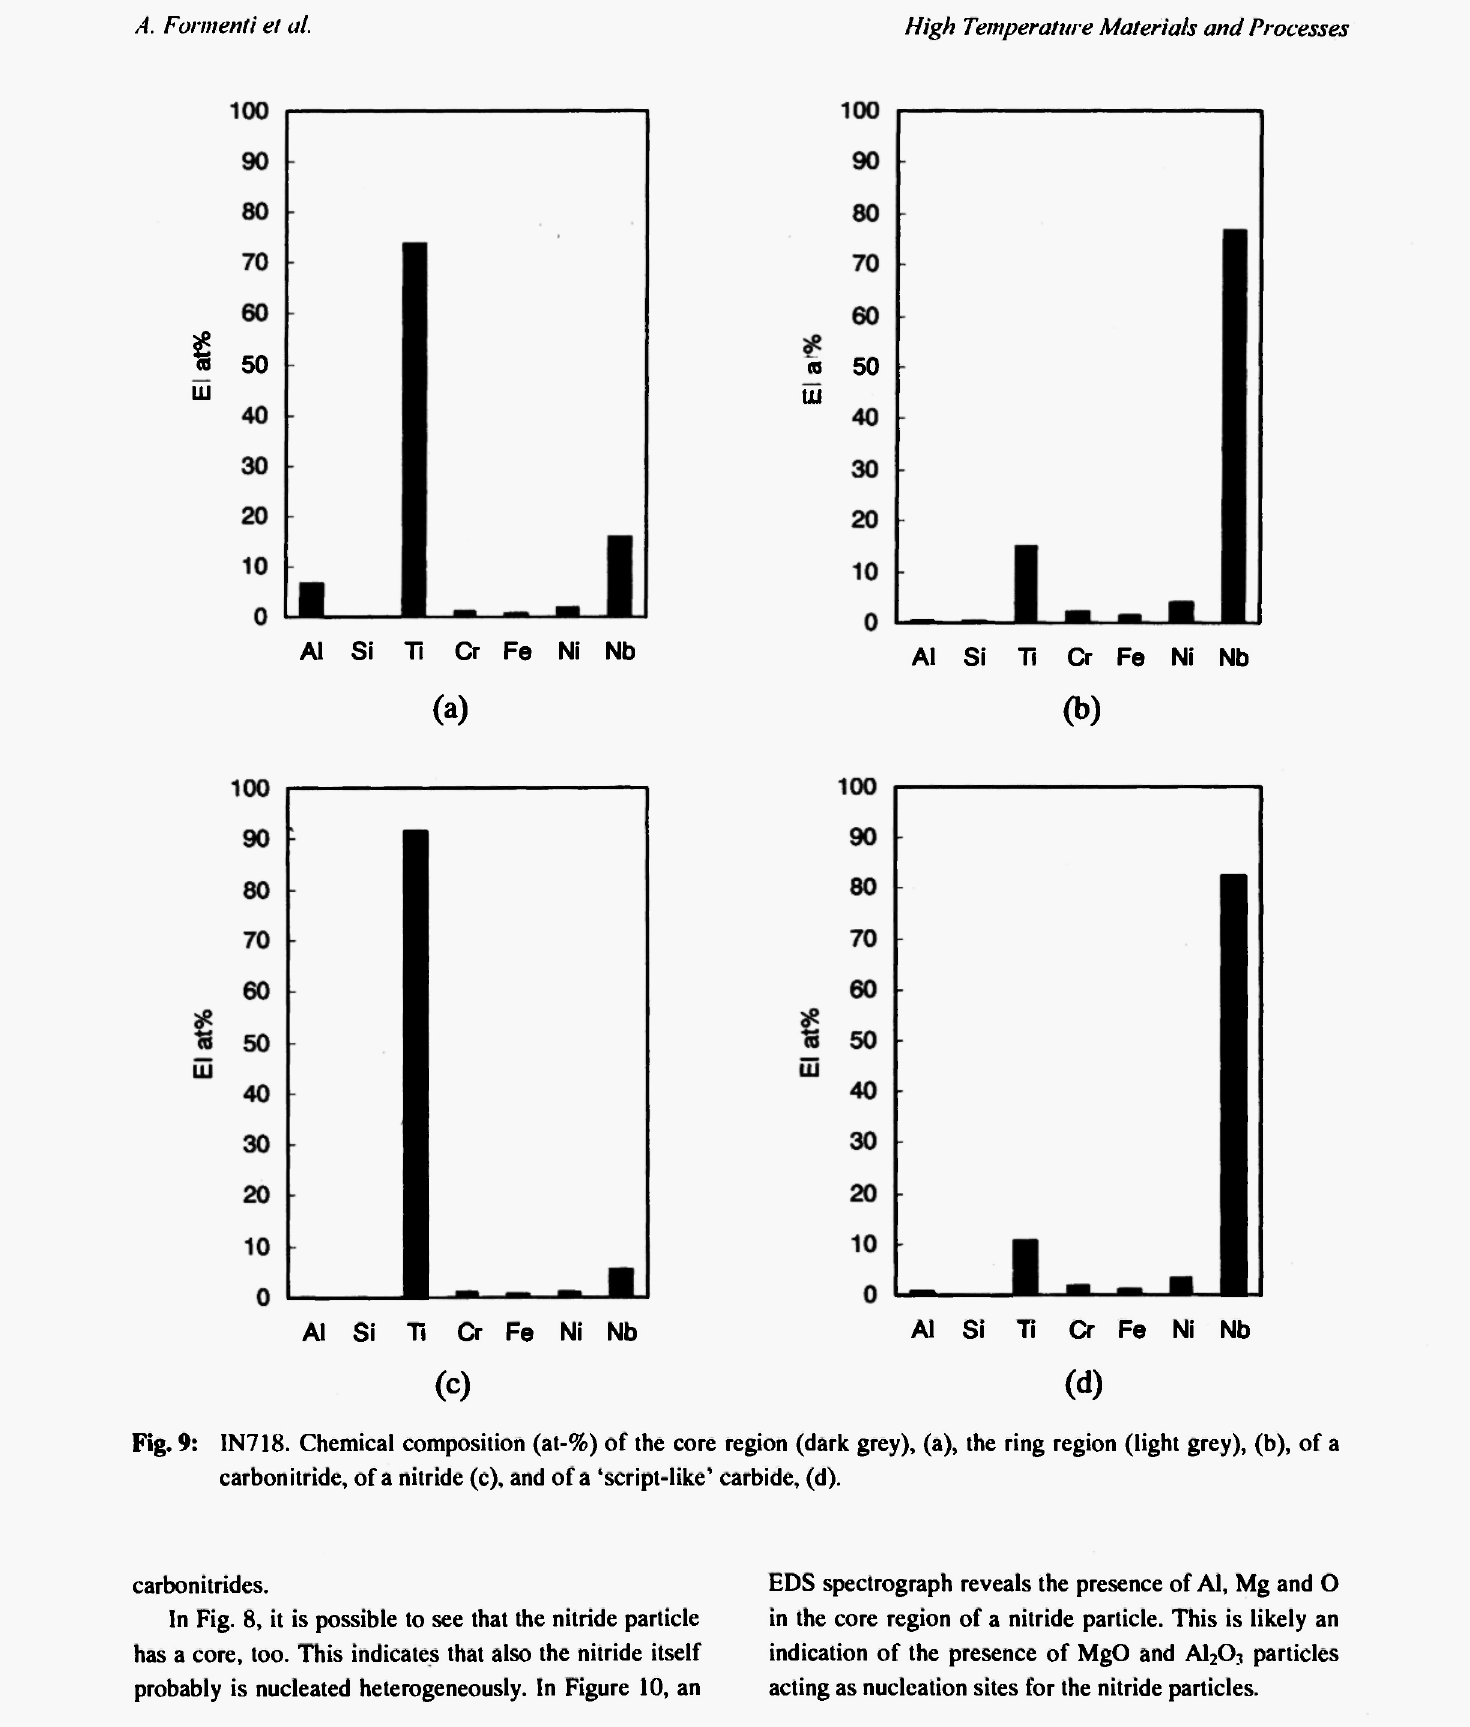
Fig. 9: IN718. Chemical composition (at-%) of the core region (dark grey), (a), the ring region (light grey), (b), of a carbonitride, of a nitride (c), and of a 'script-like' carbide, (d).